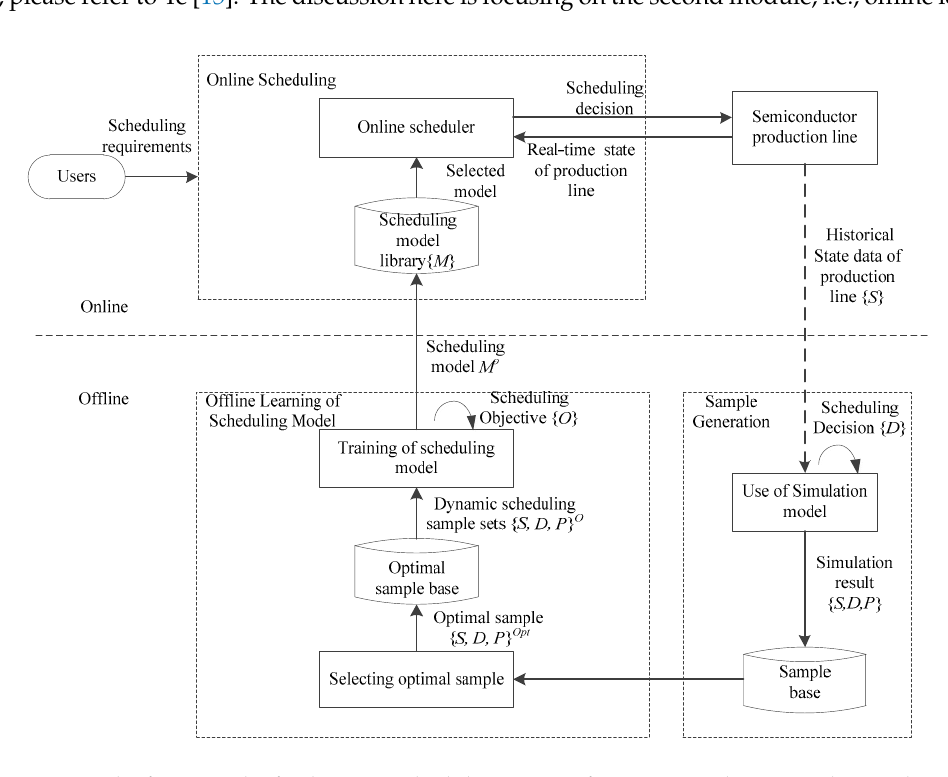
Figure 1. The framework of a dynamic scheduling system for a semiconductor production line.